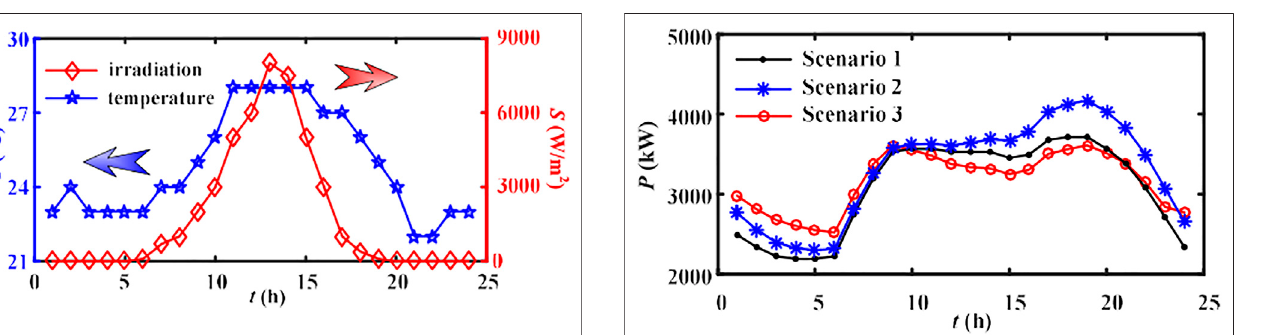
FIGURE 12 | Daily temperature and irradiation intensity.